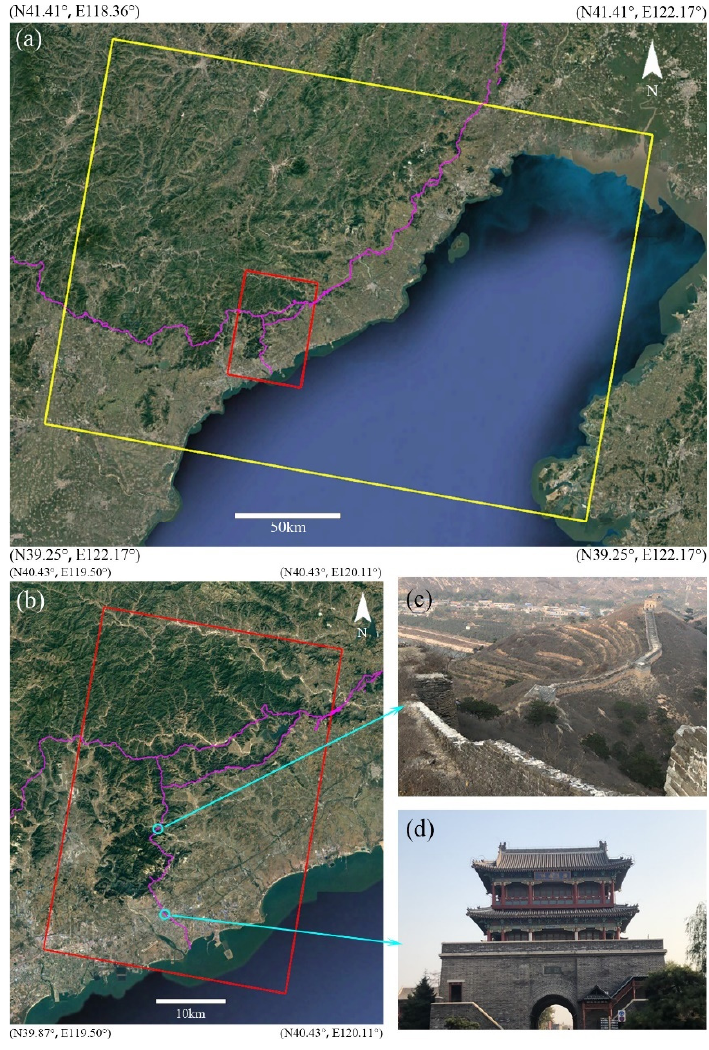
Figure 11. Overview of the study area. ( a ) Coverage of Sentinel-1 dataset (yellow rectangle) and the clipped area (red rectangle). The purple lines indicate the path of the Great Wall; ( b ) Coverage of the clipped area; and ( c , d ) two typical landscapes within the research area.